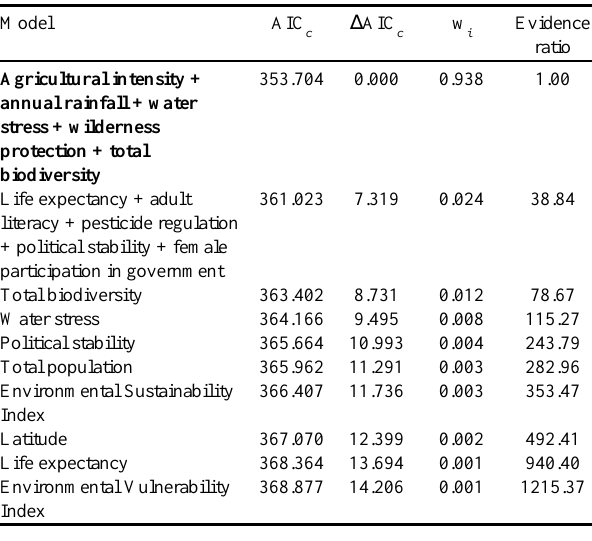
Table 6 . Parameter estimates for variables selected in the best model of social-ecological factors and the proportion of invasive birds in 100 different